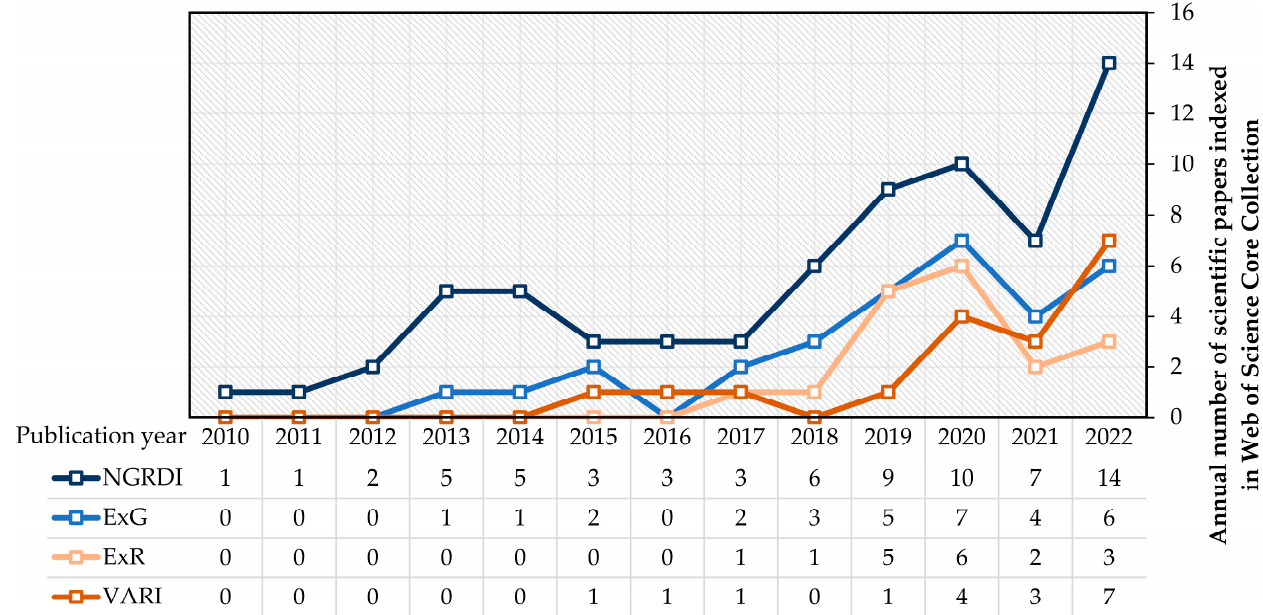
Figure 8. The number of scientific papers indexed in WoSCC since 2010 with the topic of “precision agriculture” AND individual major index based on RGB sensors.